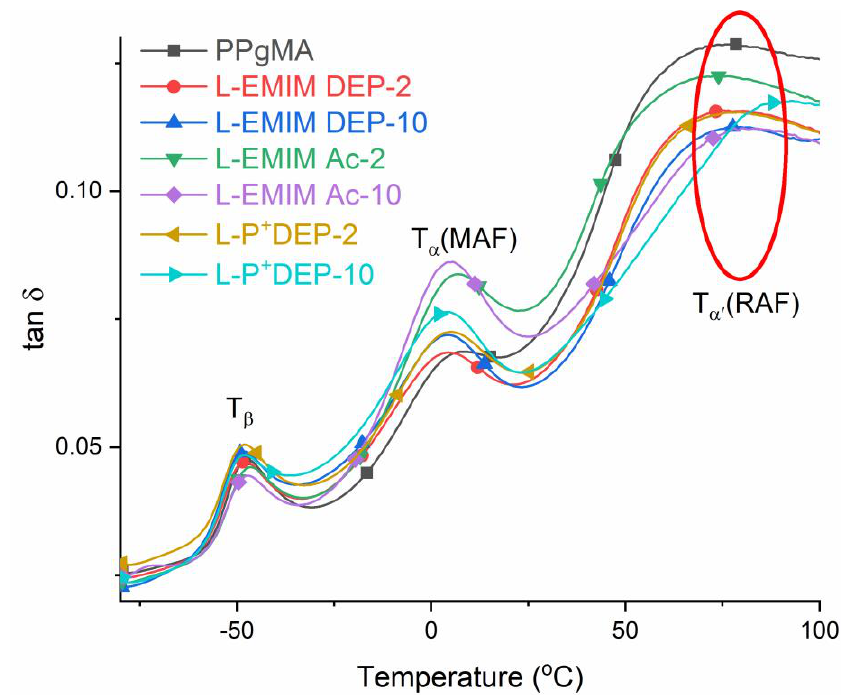
Figure 7. Loss factor (tan δ) vs. temperature for LIonomers at 1 Hz.